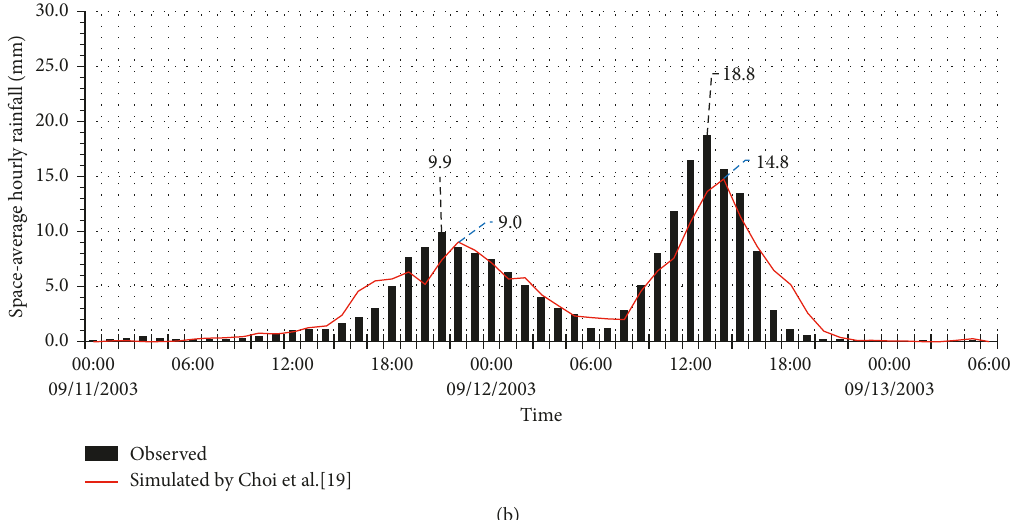
Figure 1: Comparison of observed and simulated (a) total accumulated rainfall depth and (b) hourly rainfall time series in the southeastern part of the Korean peninsula, which is the major damaged area by Typhoon Maemi [19].